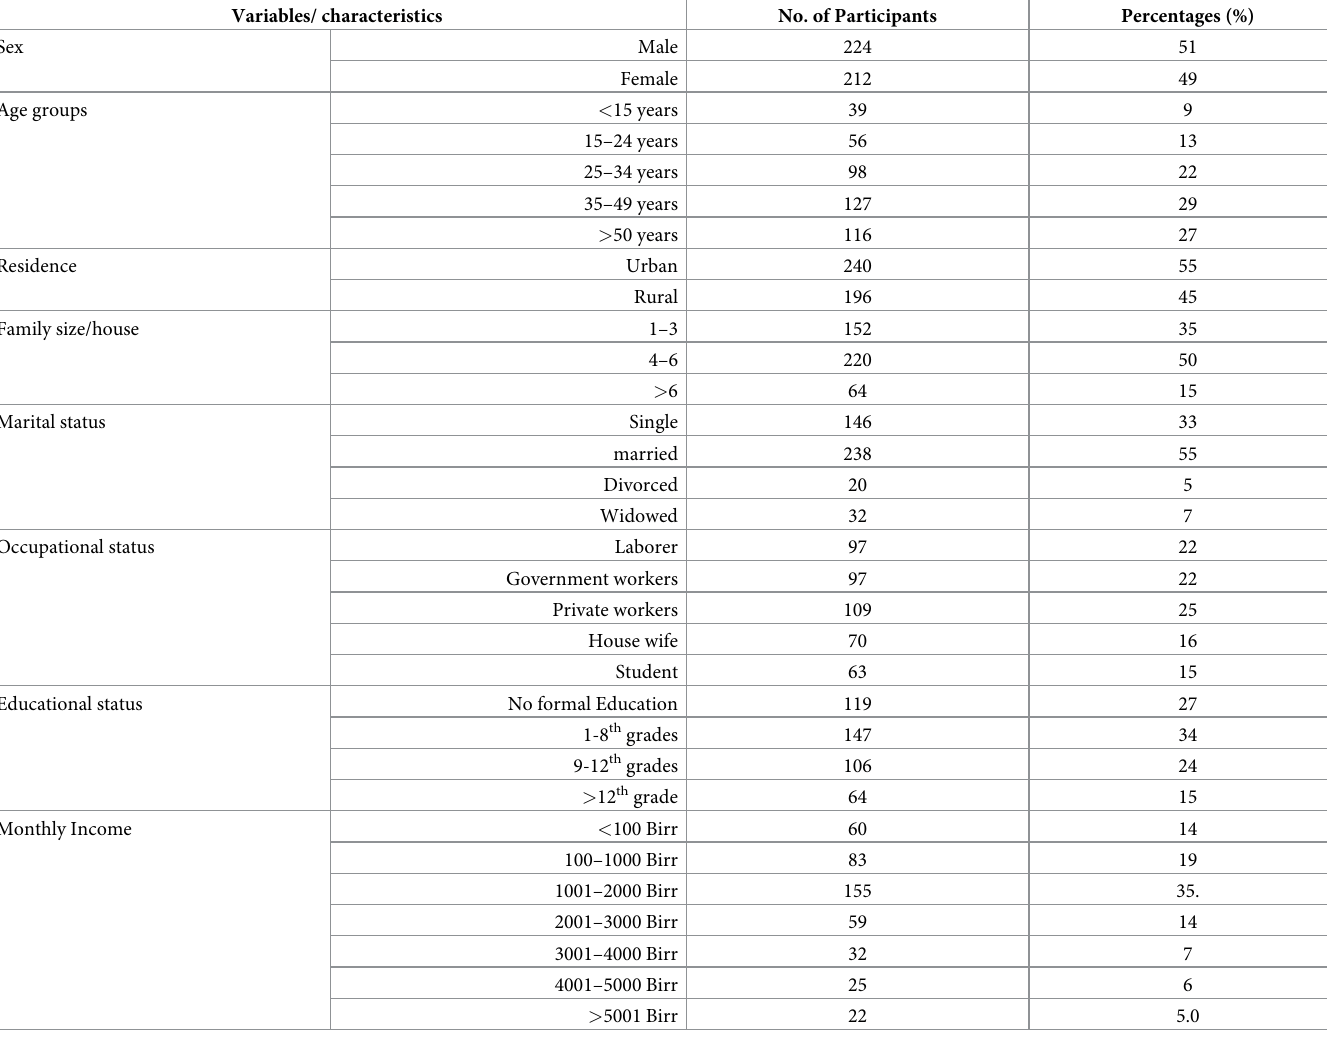
Table 1. Socio-demographic characteristics among presumptive TB patients at SPHMMC, Addis Ababa, Ethiopia, 2019. Variables/